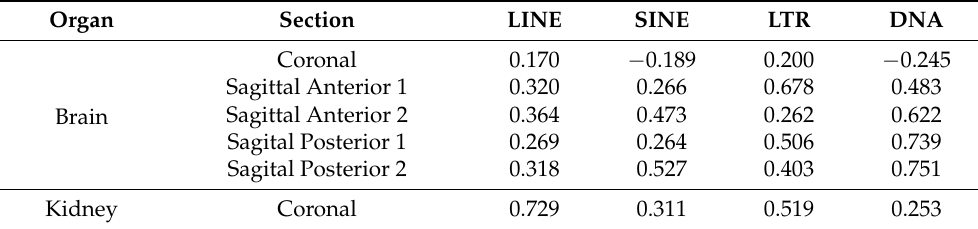
Figure 3. TE expression by class in the adult mice brain. Brain sections are indicated at the left, and the expression of each of the TE classes (indicated above) are shown. Expression levels correspond to log2 normalized counts, with the colour scale indicated at the top of each plot. “H&E”: hematoxylin and eosin-stained tissue. Table 1. Average log 2 (fold enrichment) 1 TE classes across spatial regions of analyzed